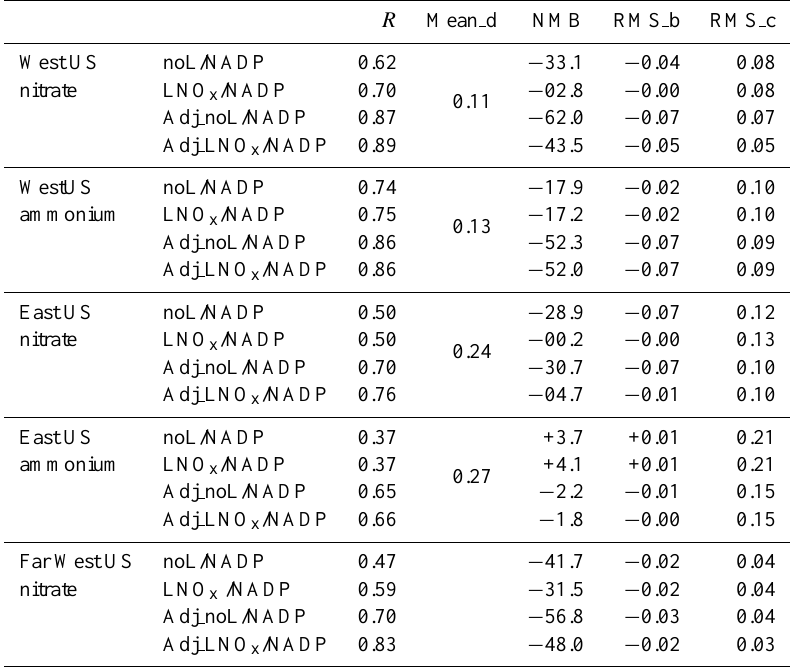
Table 3. Thirty-day average wet deposition of nitrate and ammonium from the NADP network, CMAQ simulation noL, and CMAQ simula- tion LNO x are compared for June–August 2006. Results are shown for the western United States (average of 136 months at 65 sites located west of 100 ◦ W), eastern United States (average of 397 months at 160 sites east of 100 ◦ W), and the far-western United States (nitrate only) (average of 43 months at 25 sites west of 110 ◦ W). The “Adj ” rows show the comparison when the CMAQ precipitation rates are replaced by the NADP precipitation rates when calculating the deposition rates. From left to right the columns show the region of interest, the data sets compared, the correlation coefficient, the mean of the NADP measurements (kg of Nha − 1 30days − 1 ) , the normalized mean bias, the bias, and the root mean square error after subtracting the